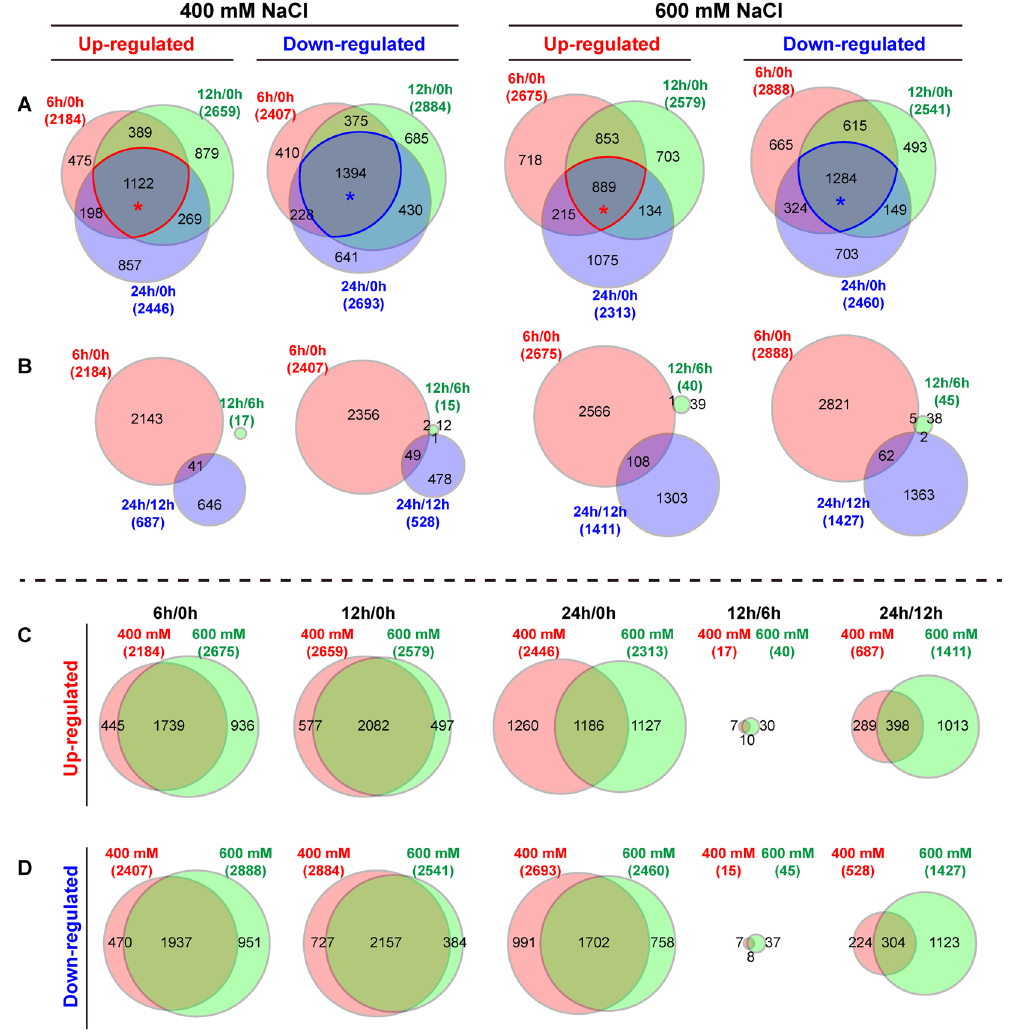
Figure 2. Venn diagrams show different comparisons of P . euphratica during salt stress. ( A ) Overlap of comparison 6 h/0 h, 12 h/0 h, and 24 h/0 h of up- or down-regulated genes after 400 mM or 600 mM NaCl treatment. Red and green asterisks indicate the overlapped up- and down-regulated core genes in the three comparisons. ( B ) Overlap of comparison 6 h/0 h, 12 h/6 h, and 24 h/12 h of up- or down-regulated genes after 400 mM or 600 mM NaCl treatment. ( C ) Overlap of up-regulated genes between 400 mM and 60 mM NaCl treatments in five comparisons (6 h/0 h, 12 h/0 h, 24 h/0 h, 12 h/6 h, and 24 h/12 h). ( D ) Overlap of down- regulated genes between 400 mM and 60 mM NaCl treatments in five comparisons (6 h/0 h, 12 h/0 h, 24 h/0 h, 12 h/6 h, and 24 h/12 h). The circular area corresponding to the gene number in each